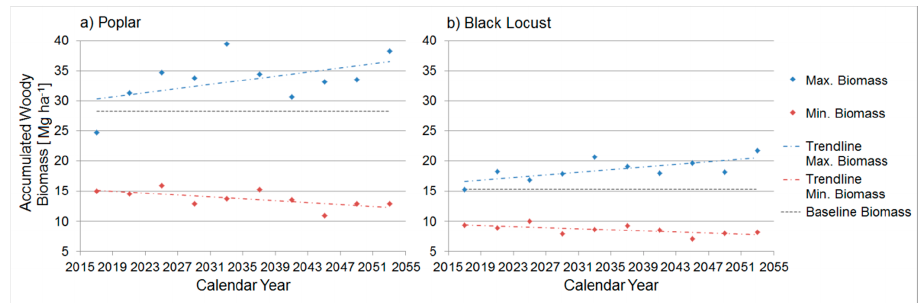
Figure 7. The range of possible accumulated woody biomass shown by maximum (blue) and minimum (red) values obtained after four years of growth with respect to the ten established growing periods for ( a ) poplar and ( b ) black locust. Trend lines for the woody biomass are described by dash-dotted lines. The dashed lines represent the woody biomass, as per reference period.